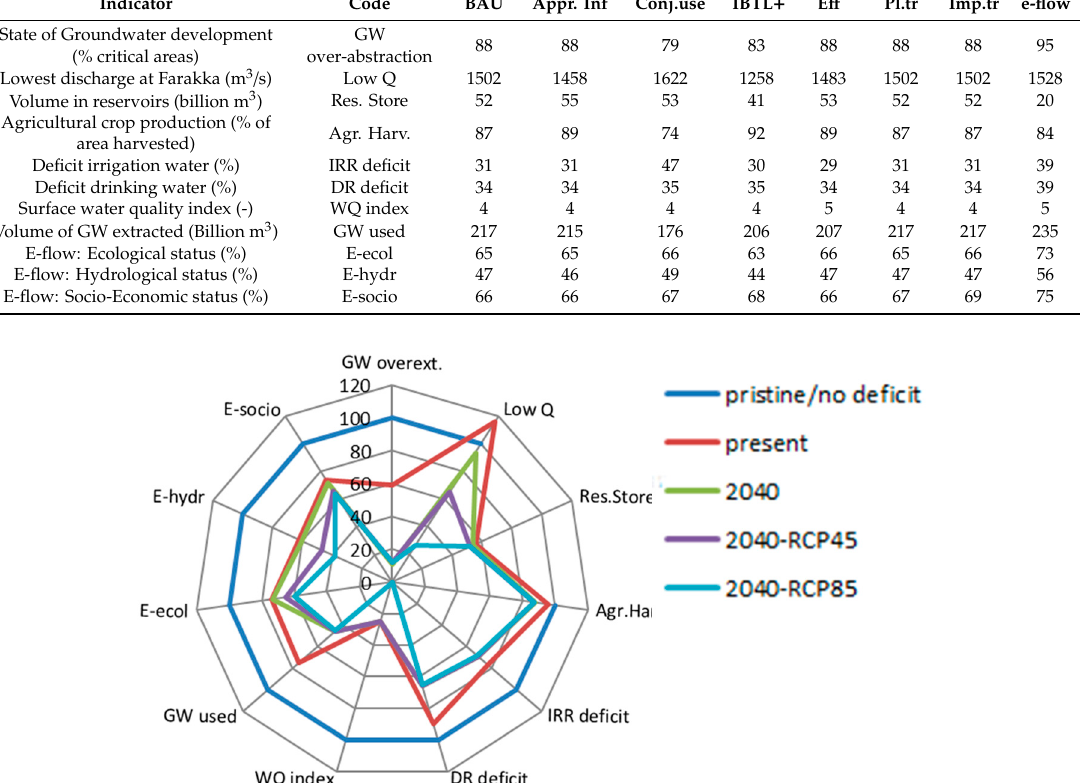
Table 6. Basin wide indicator scores for eight strategies under the IPCC 2040_RCP4.5 scenario.